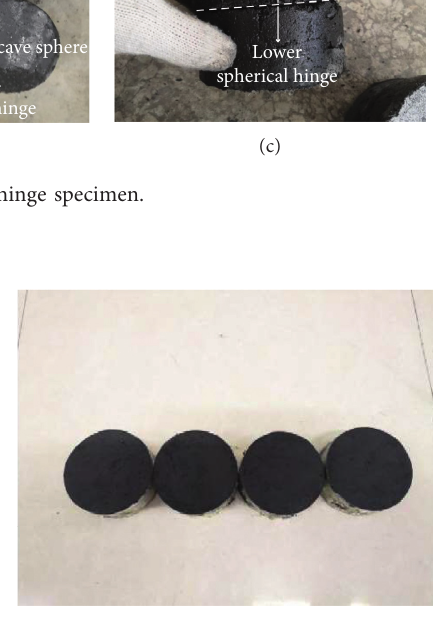
Figure 5: Steam curing box. Figure 6: UHPC spherical